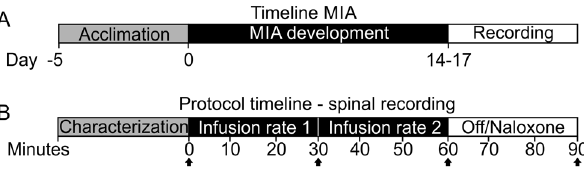
Figure 1. Experimental timelines. (A) MIA Sensitization timeline with recording on a single day between 14–17 days post injection (B) Protocol on the day of recording. Black arrows denote time points at which dried blood spot samples were taken for drug exposure measurement.